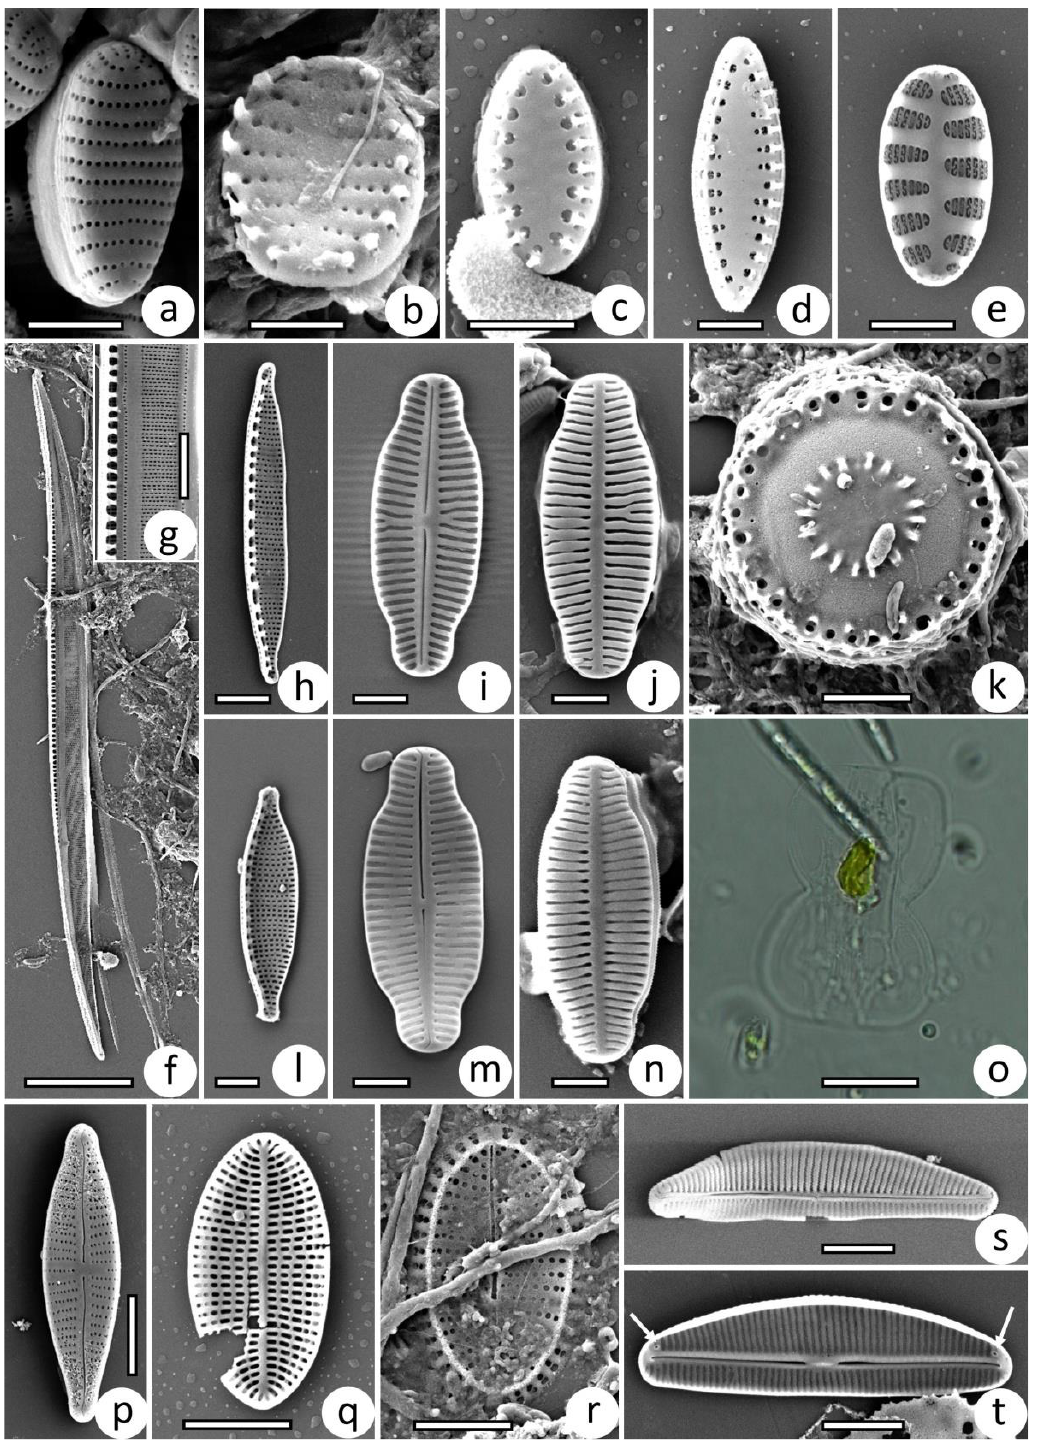
Figure 8. Morphology of the diatoms observed (LM — o , SEM — a – n , p – t ): ( a ) Martyana atomus ; ( b ) Nanofrustulum trainorii ; ( c , d ) Pseudostaurosira cf. elliptica ; ( e ) Staurosirella pinnata ; ( f , g ) Nitzschia sigma ; ( h ) Nitzschia paleacea ; ( i , j , m , n ) Planothidium sp.; ( k ) Paralia sp.; ( l ) Nitzschia microcephala ; ( o ) Entomoneis paludosa var. subsalina , ( p ) Gomphonema parvulum ; ( q ) Cocconeis placentula var. euglypta ; ( r ) Cocconeis placentula ; ( s , t ) Amphora micrometra ( s — external view of valve; t — internal view of valve, arrows indicate portulae). Scale bars: 2 µm — a – e , s , t ; 5 µm — g , k , p – r ; 20 µm — f , o .